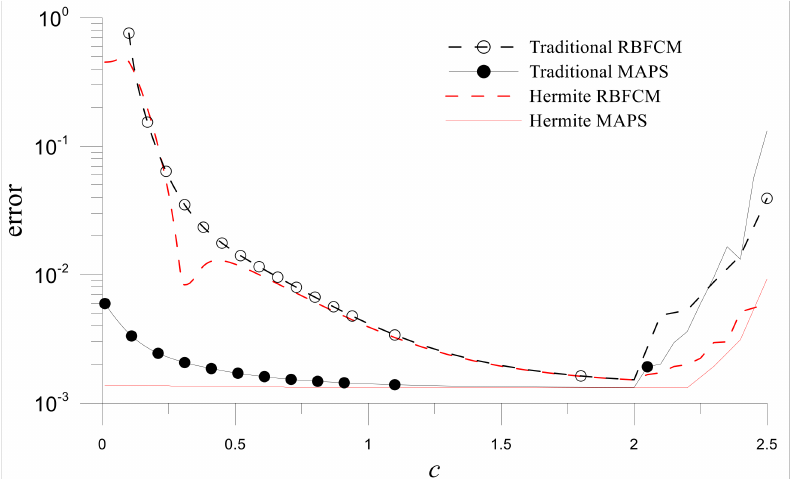
Figure 12. Errors of numerical solutions obtained by the four numerical methods with different values of c at t = 6 for Example